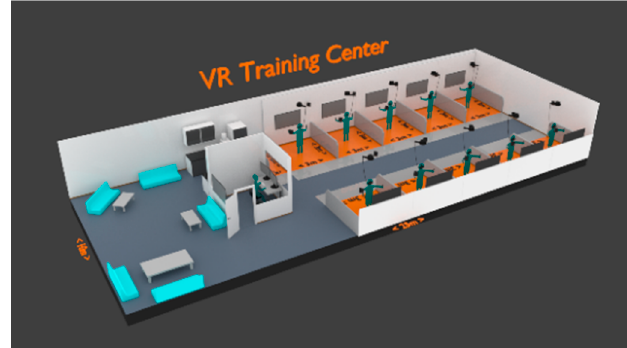
Figure 8. Immersive Safe Oceans Technology’s training center.